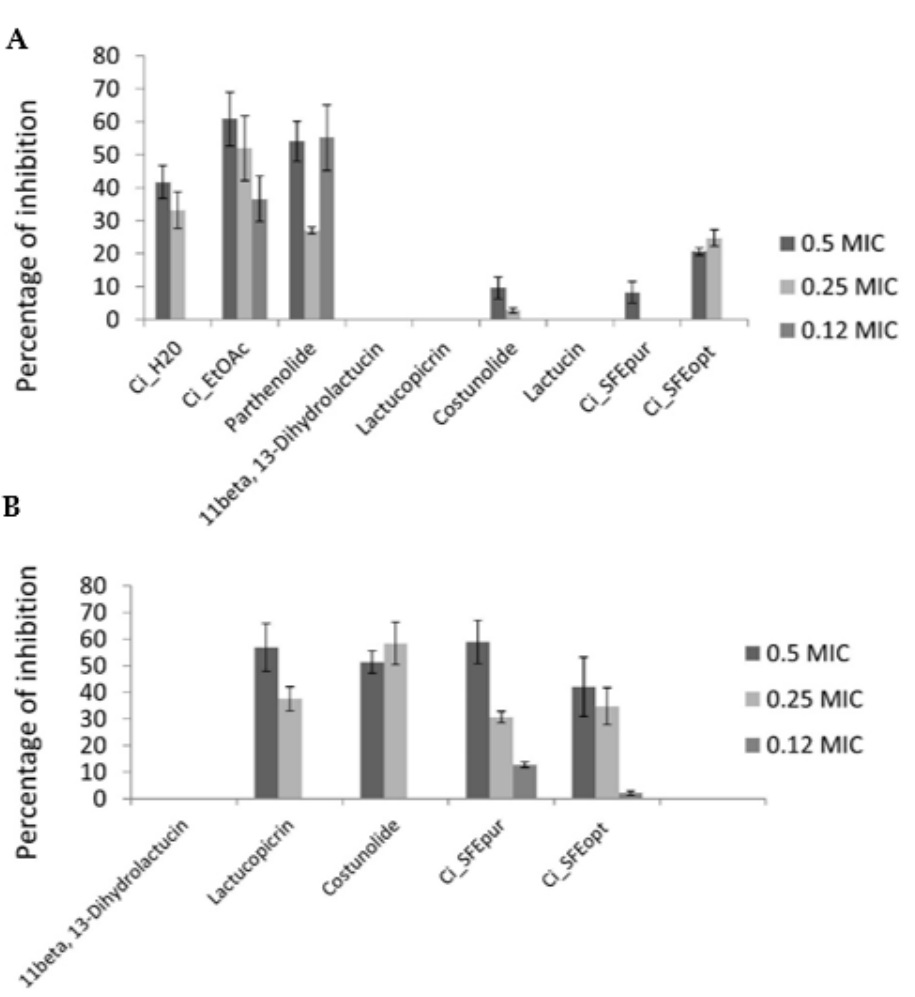
Figure 3. Percentage inhibition of biofilm formation in ( A ) C. albicans 475/15 and ( B ) P. aeruginosa IBRS P001 after treatment with chicory extracts and pure compounds. Results are presented as a mean (± stdev) of triplicates.